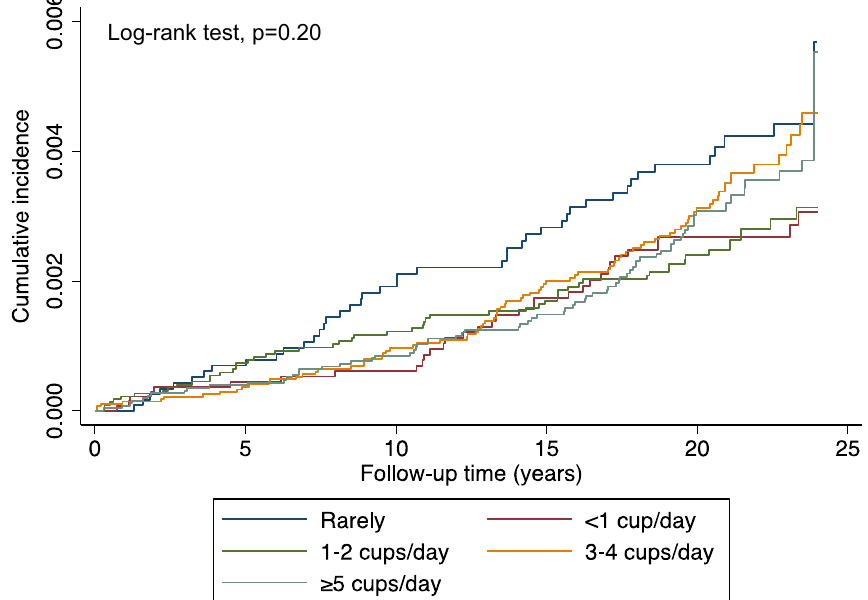
Figure 1. Kaplan–Meier survival curves of the cumulative incidence of kidney cancer among JPHC participants with different green tea consumption.